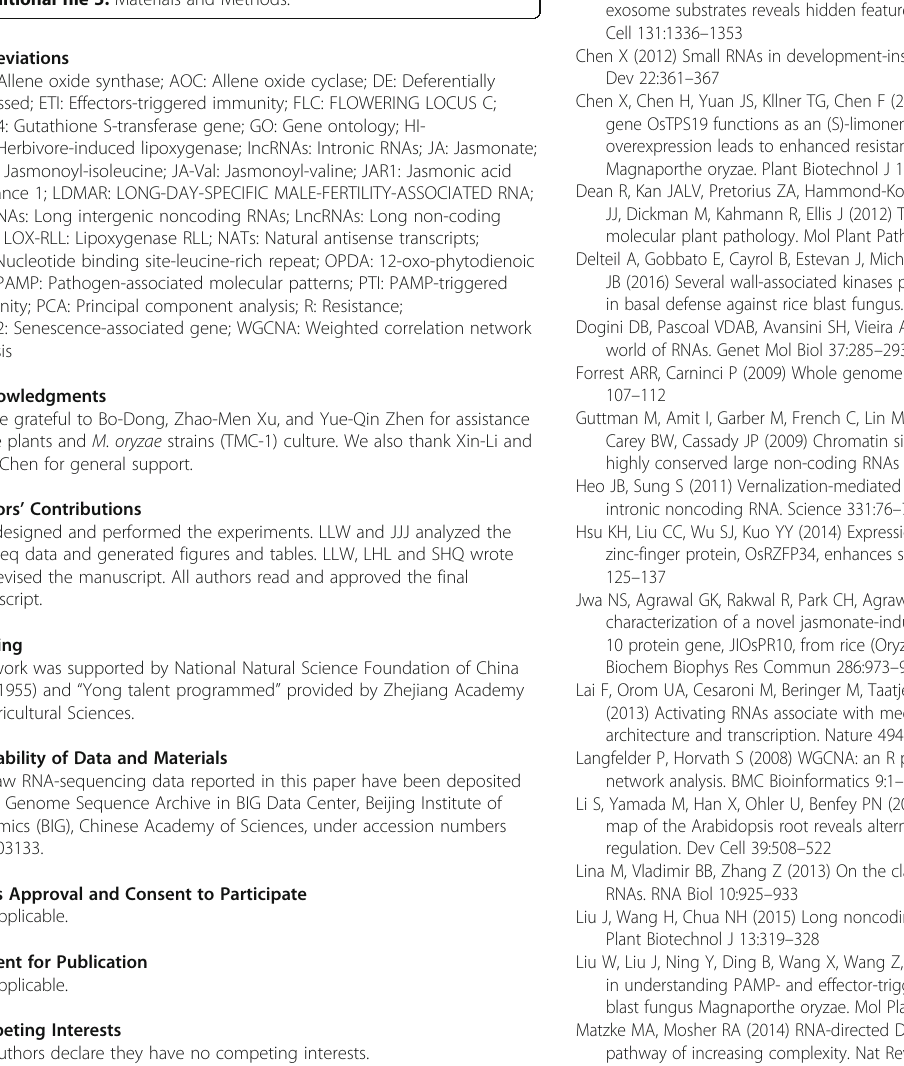
Additional file 1: Table S1. Summary of LncRNA-sequencing used in this study. Additional file 2: Table S2. LncRNAs responsive to M. oryzae infection. Additional file 3: Table S3. The information of blast pathogen resistance-related genes and associated LncRNAs in Fig. 4. Additional file 4: Table S4. Primers used in